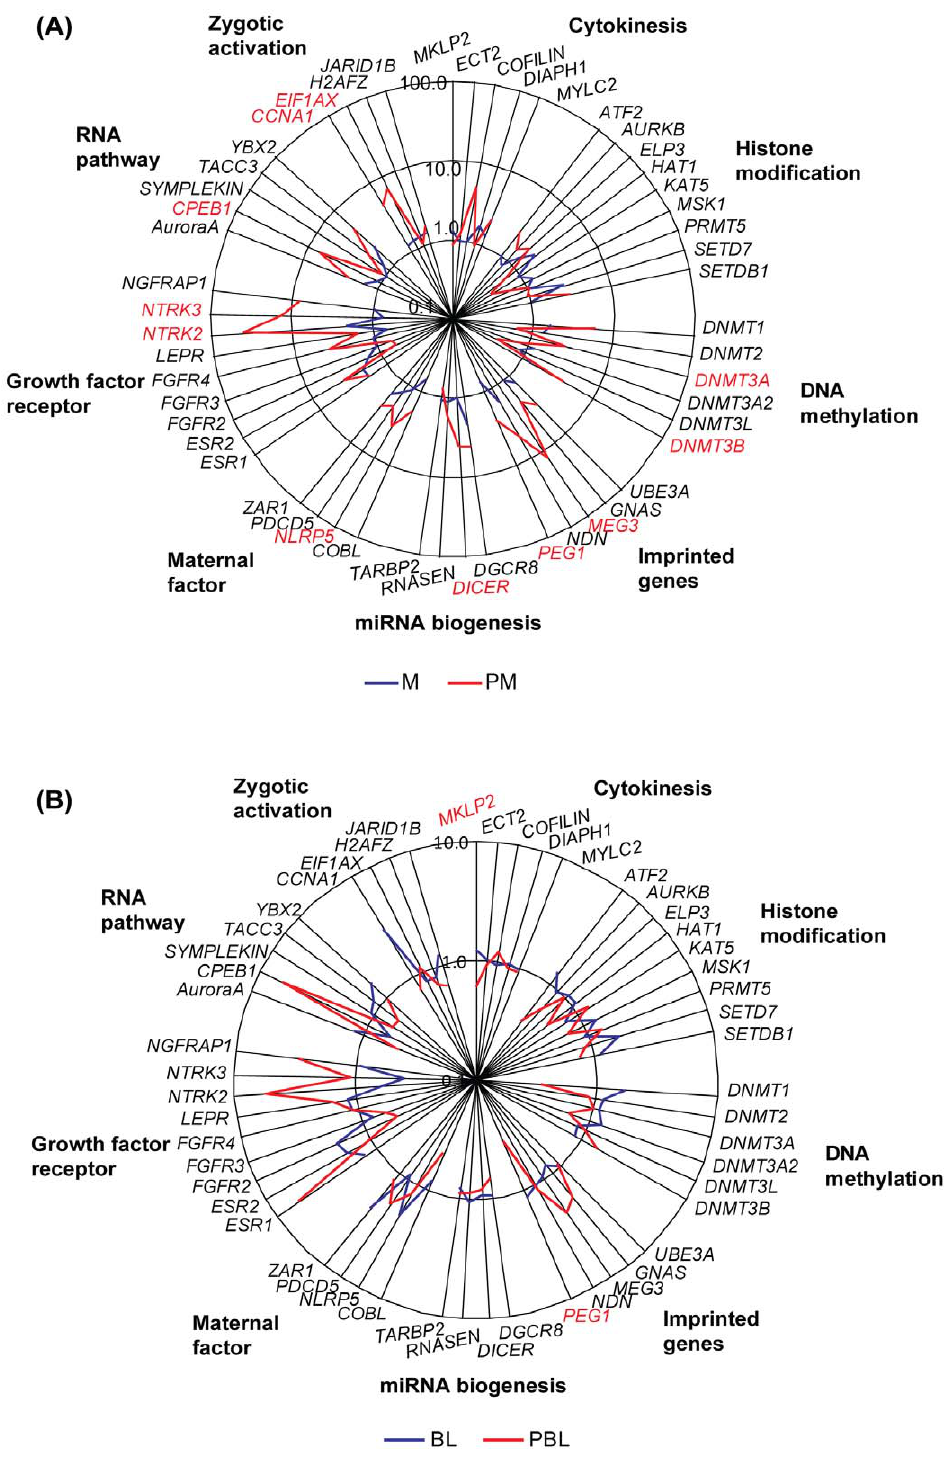
Figure 4. Gene expression of parthenogenic embryos. The average mRNA expression level of morulas (A) and blastocysts (B) from parthenogenesis and IVF/ICSI were displayed. Red color: Significantly differentially expressed. PM=parthenogenic morula, PBL=parthenogenic blastocyst.